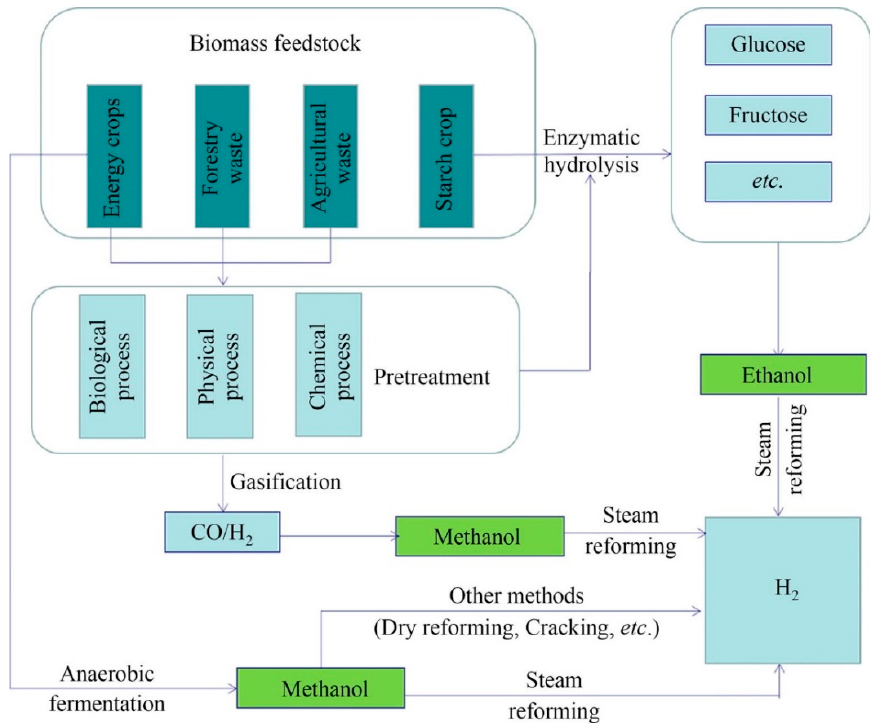
Figure 9. Hydrogen production routes from biomass [1]. Reprinted with permission from Elsevier.